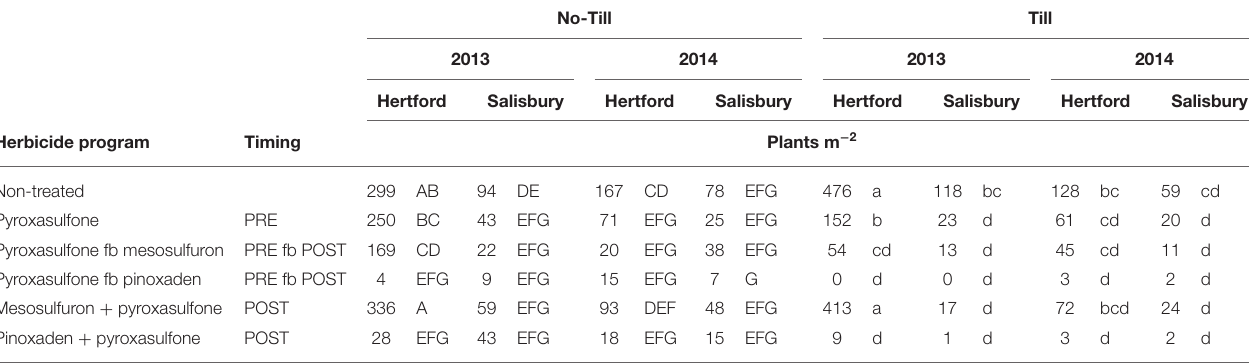
TABLE 5 | Italian ryegrass seed head density counts prior to winter wheat harvest across separated by experiment locations (Hertford and Salisbury, North Carolina) and years (2013 and 2014); experiments were separated by tillage environment.